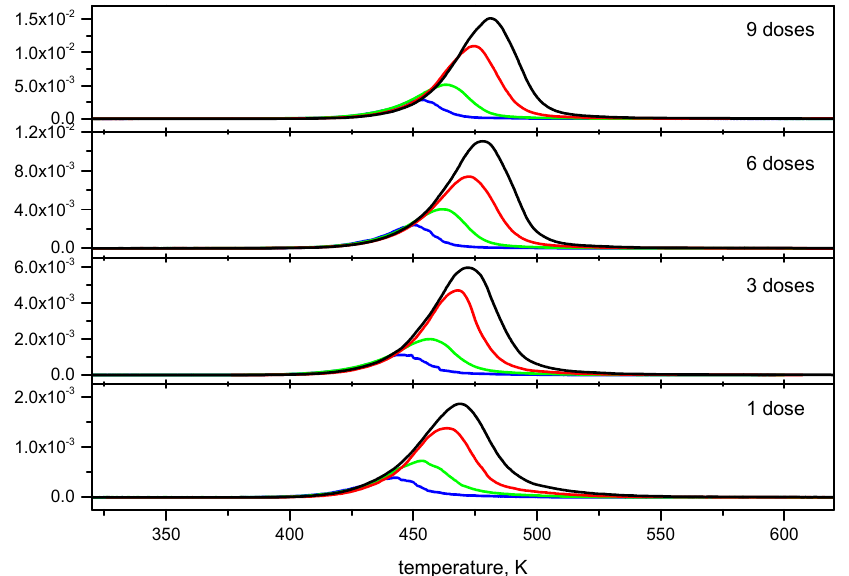
Figure 5. CHA–7.5 TPSR profiles measured at different heating rates (black curves—15 K · min − 1 ; red curves—10 K · min − 1 ; green curves—5 K · min − 1 ; blue curves—2.5 K · min − 1 ), y-axis is rate of formation of ethylene in µ mol · s − 1 .